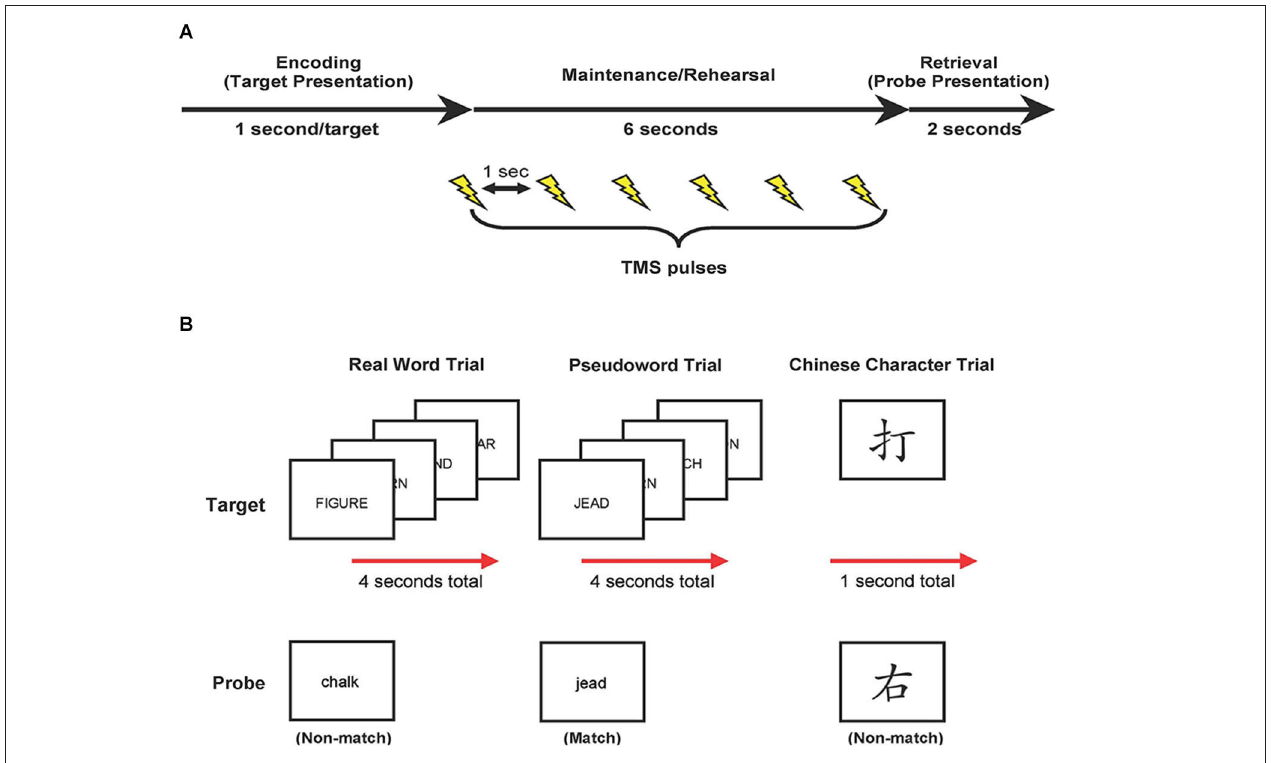
participants compared a probe item to the targets and indicated match or non-match with a button press response. (B) Examples of real word, pseudoword, and Chinese character trial